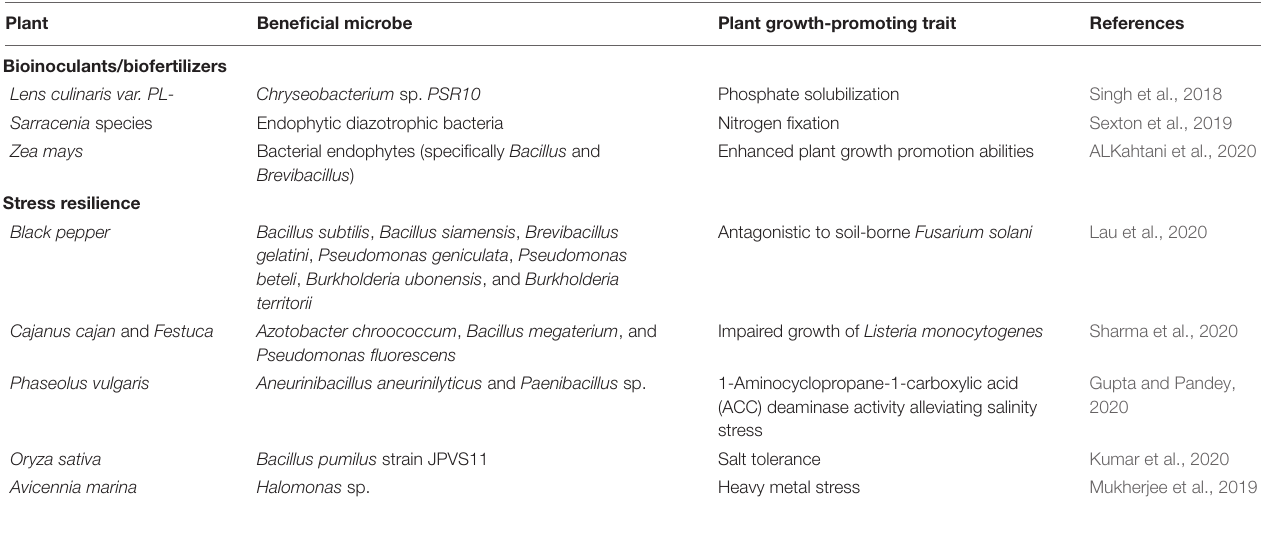
TABLE 2 | Microbial inoculations enhancing plant growth-promoting traits. Plant Beneficial